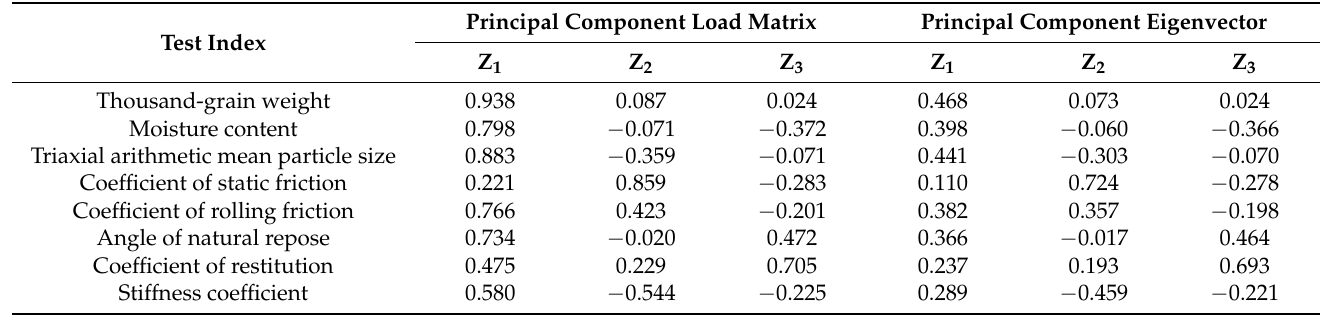
Table 6. Load matrix and eigenvector of each principal